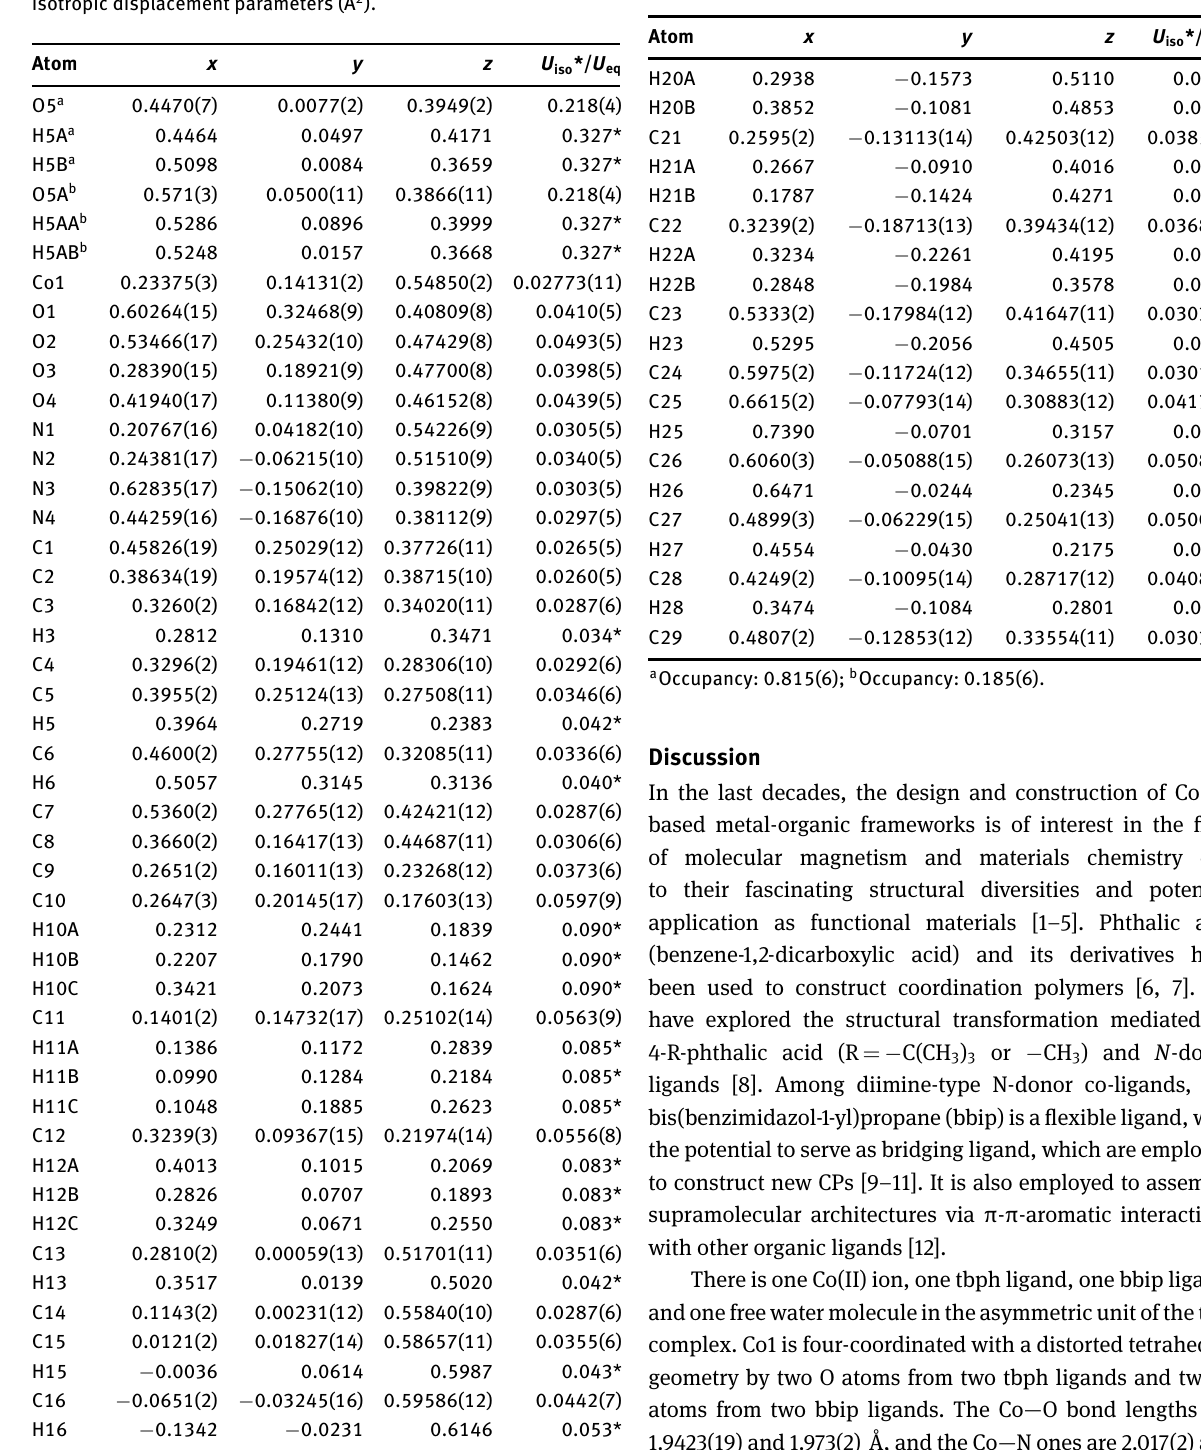
Table 2: Fractional atomic coordinates and isotropic or equivalent isotropic displacement parameters (Å 2